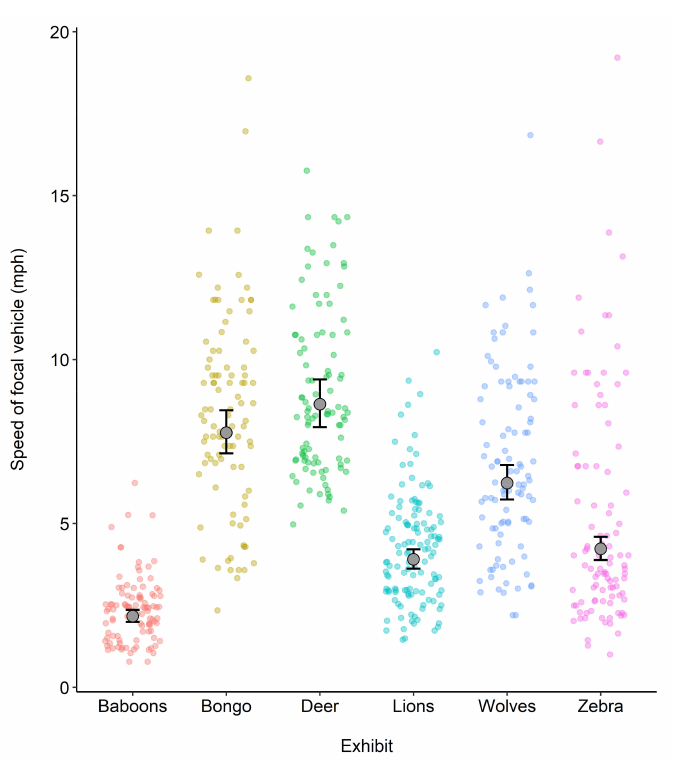
Figure 2. Average speed of focal vehicle across six exhibits on the drive at Knowsley Safari. All comparisons barring bongo/deer and lions/zebra are